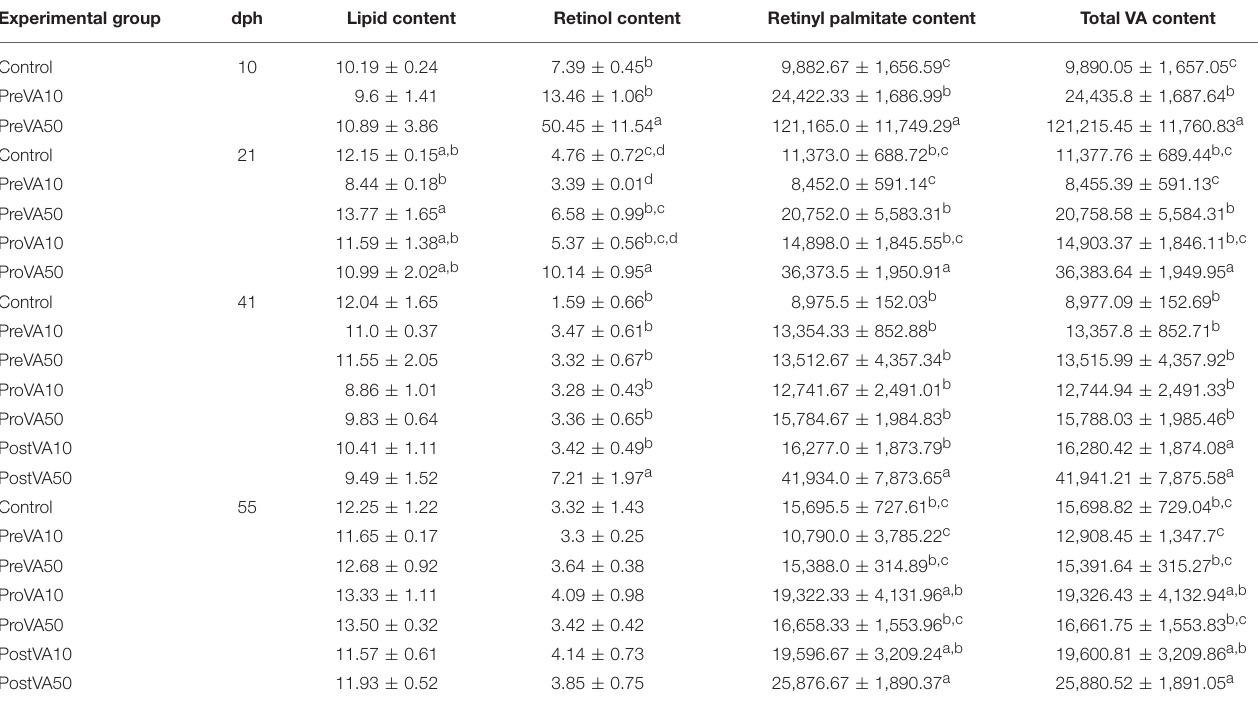
TABLE 2 | Total lipid and retinoid (mean ± SD) content in Senegalese sole individuals at 10, 21, 41, and 55 dph fed experimental